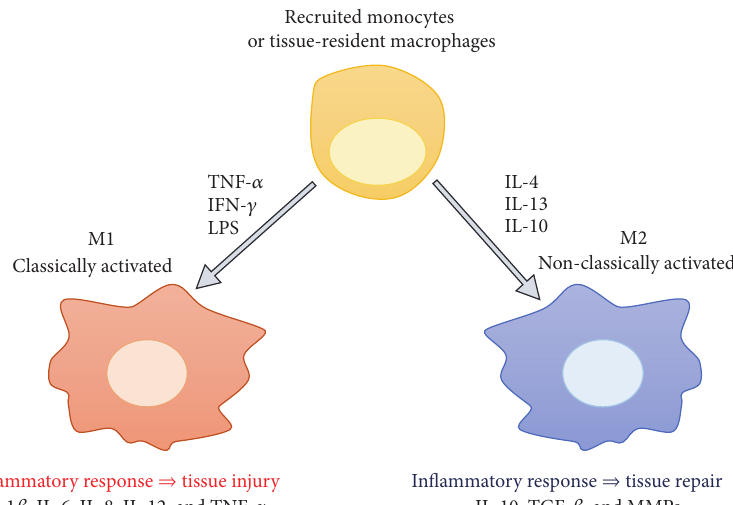
Figure 2: Schematic summary of macrophage polarization. Monocytes from peripheral blood differentiate in response to mediators in tissues, giving rise to different subsets: classically (M1) or alternatively (M2) activated macrophages that, respectively, lead to “bad” or “good” proinflammatory